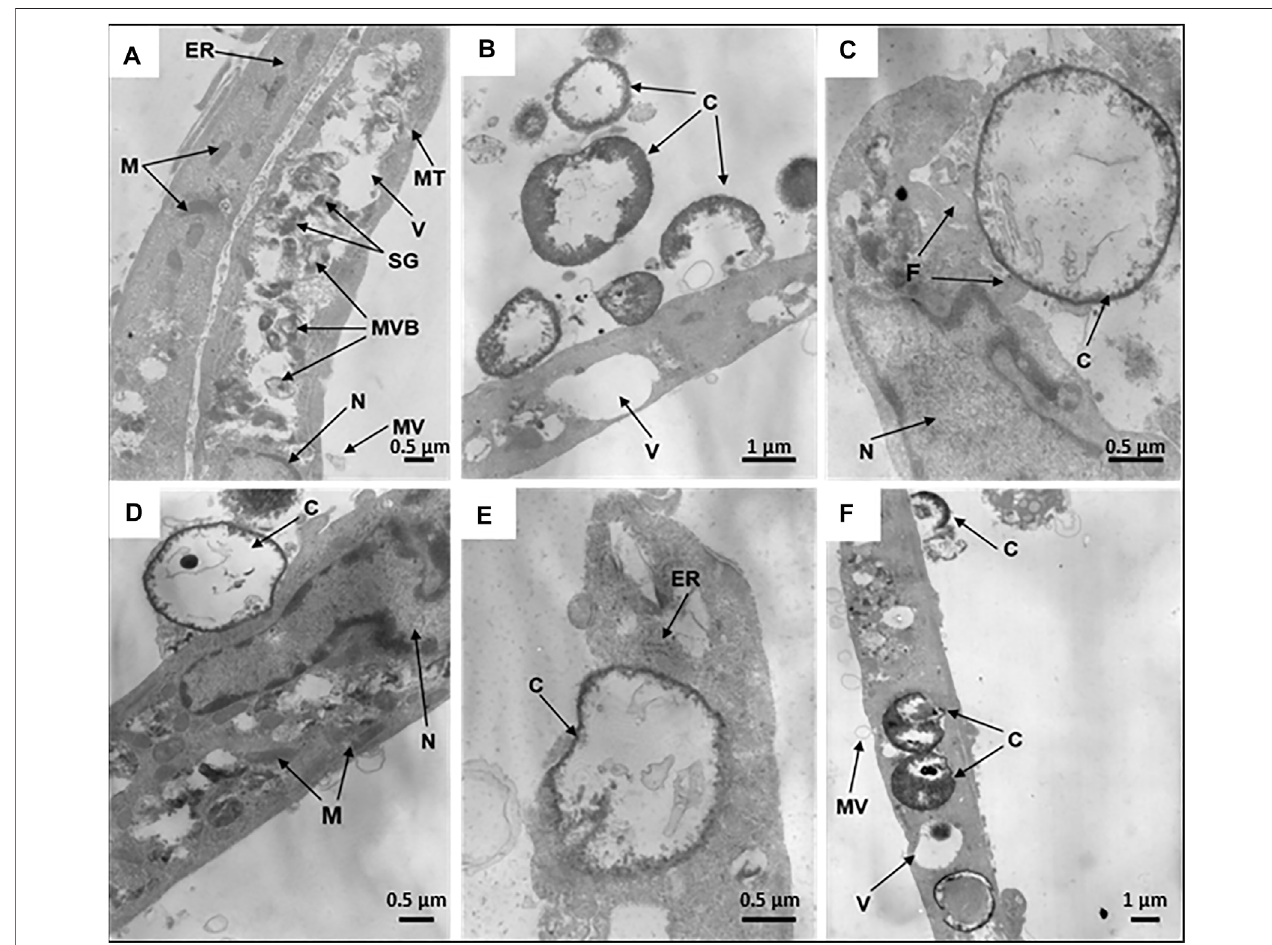
FIGURE 4 | Internalization of synthetic microcapsules by hMSCs. Representative transmission electron micrographs of native hMSCs in the absence of microcapsules (A) and stepwise internalization of microcapsules 24 h post-phagocytosis at a 1:10 cell/microcapsule ratio. (B) Primary contacts of cells with microcapsules. (C,D) Capturingofmicrocapsulesby fi lopodiaorcellsbodies,respectively. (E) Dippingofmicrocapsulesintothecellcytoplasm. (F) Microcapsulesinside a cell. Designations: C, microcapsules; N, nucleus; F, fi lopodia; ER, endoplasmic reticulum; V, vacuoles; M, mitochondria; SG, secretory granules; MT, microtubules; MVB, multivesicular bodies; MV,